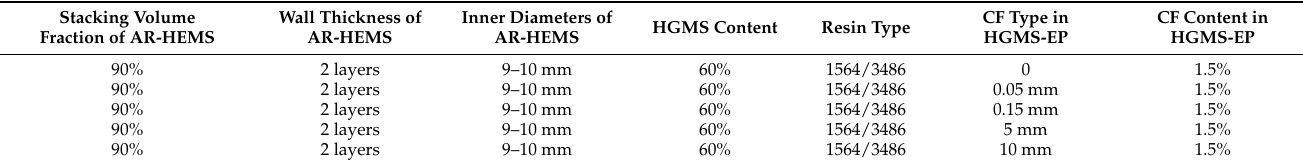
Table 5. Five samples of ESF reinforced by CF with different